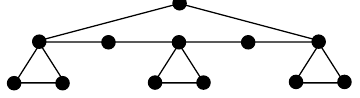
Figure 1: Graph G with e ∞